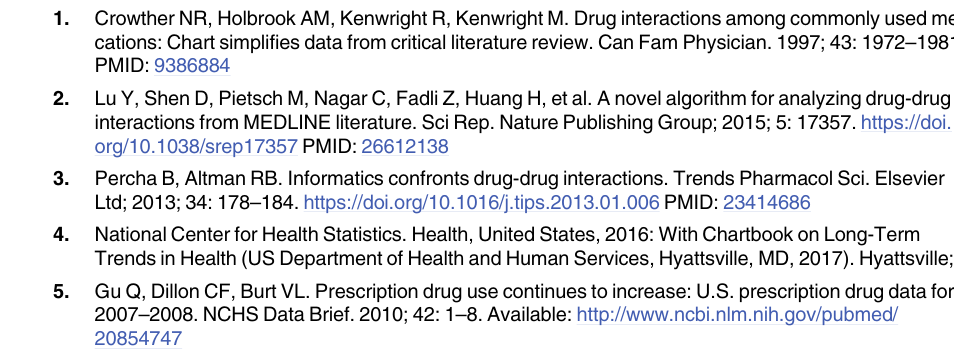
S3 Table. Tab 1: Performance comparison of XGBoost with several other algorithms with and without genetic interaction features. Tab 2: comparison of our method with Zhao and Cheng, 2014. Tab 3: model performance using only genetic interaction features of target sequence similarity features. S4 Table. A list of 432 new adverse DDI predictions. S5 Table. A list of all drug pairs in the training set and a list of all drug pairs in the test set. S6 Table. Side effects, indications, human gene targets and their yeast homolog of all drugs that appear in the training set or the test